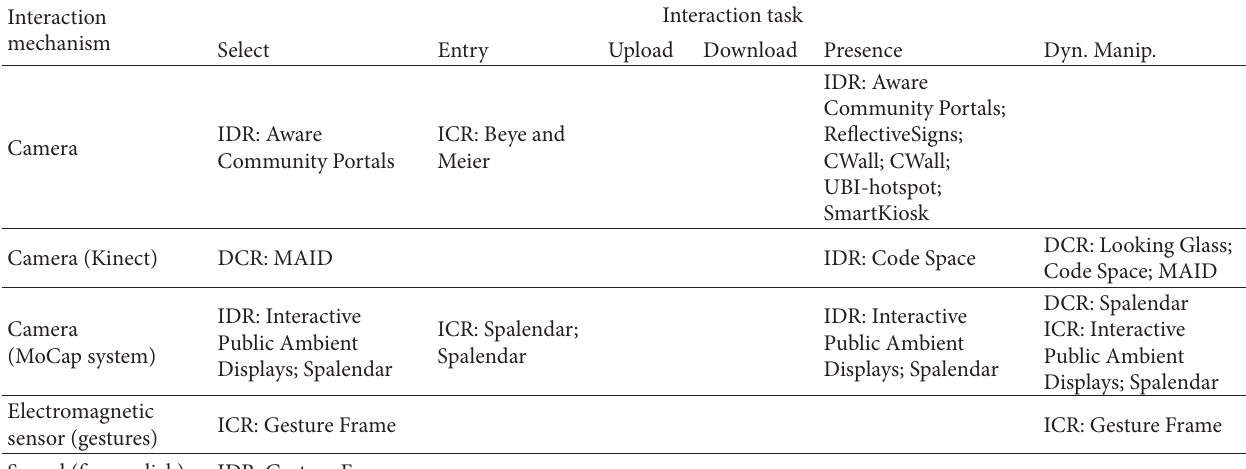
Table 4: Mapping between interaction tasks and device-free interaction mechanisms.